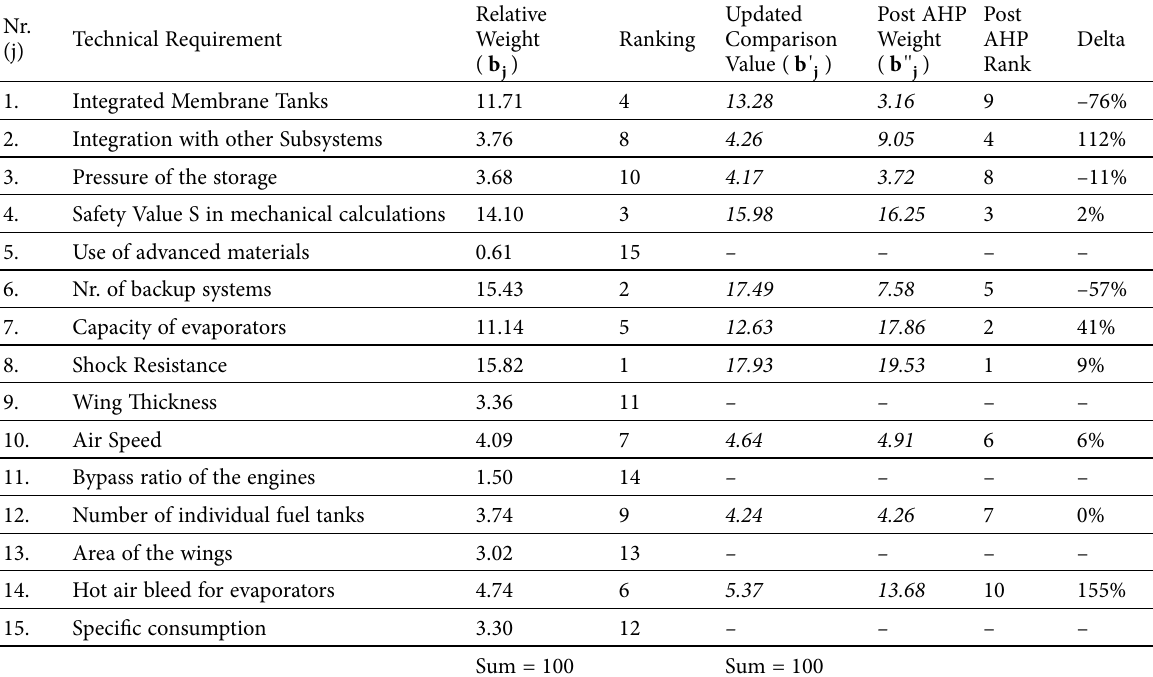
Table 3. Weight factors and associated ranking of technical requirements in the first iteration Nr.